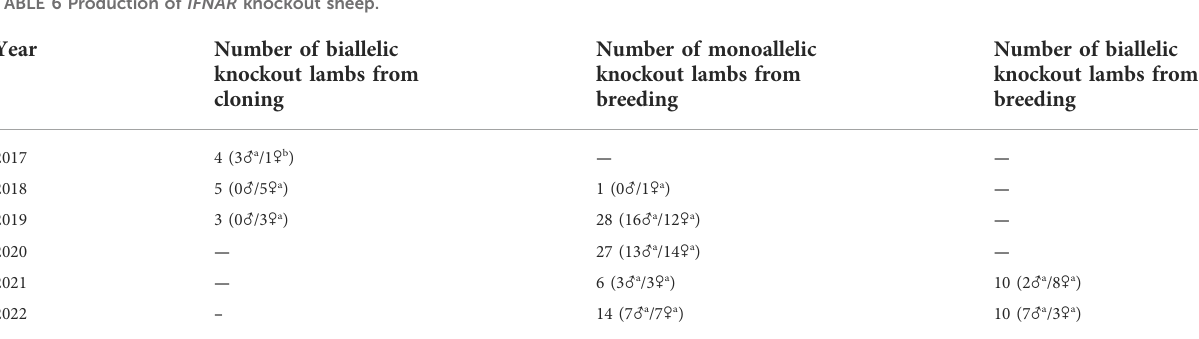
TABLE 6 Production of IFNAR knockout